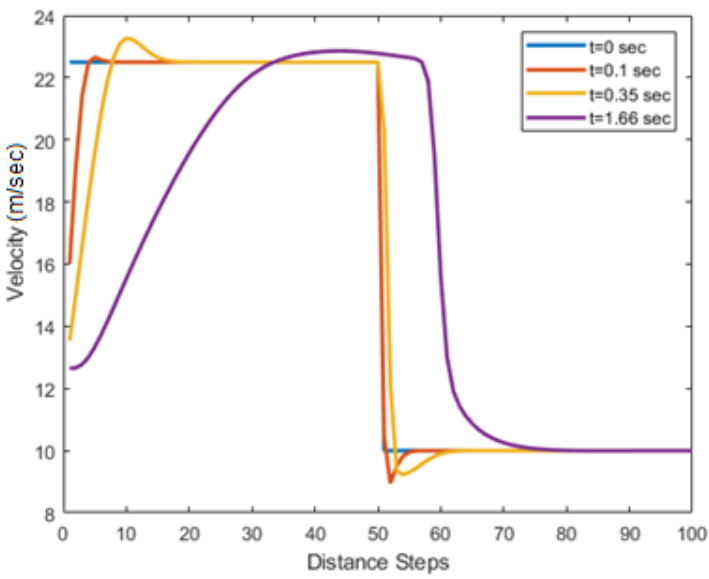
Figure 7. Velocity behavior of proposed model on straight road with ingress traffic.